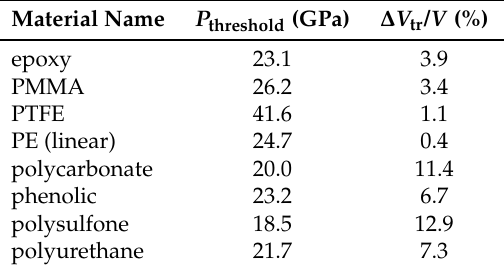
Table 2. Representative polymers, their threshold pressure for decomposition on their principal Hugoniot, and the percentage volume change upon decomposition. As taken from Ref. [36].